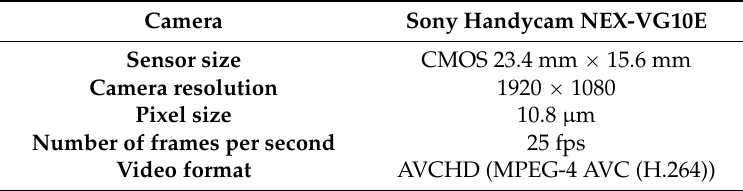
Table 2. The main parameters of the Sony Handycam NEX-VG10E video camera.